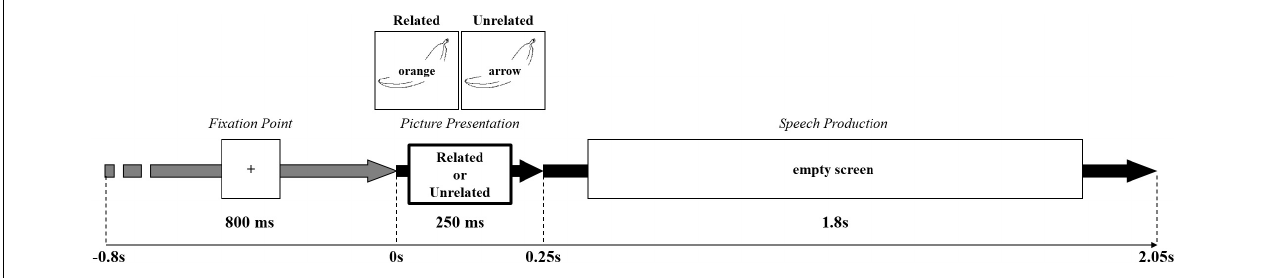
FIGURE 1 | Experimental Procedure. The beginning of the trial was signaled by a “+” appearing in the center of the screen for 800 ms, followed by the picture presentation with a related or unrelated distractor for 250 ms. During speech production, an empty screen appeared for minimum 1800 ms. The Figure shows an example of a semantically related and unrelated